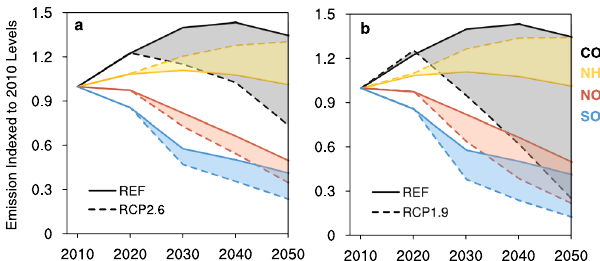
Fig. 3 Emission trends of CO 2 , NH 3 , NO X , and SO 2 under various scenarios in China through 2010 – 2050. a Comparison of emissions between SSP1_REF and SSP1_RCP2.6 indexed to 2010 levels. The solid lines represent the REF, while the dashed lines represent RCPs. b is the same as ( a ), but for the comparison between SSP1_REF and